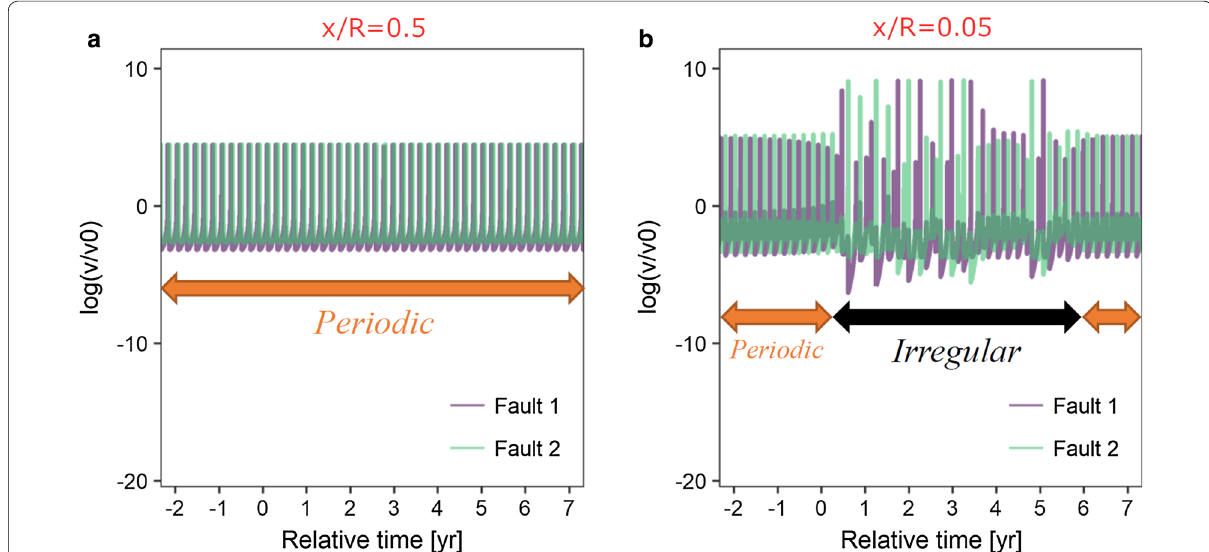
Fig. 3 Temporal evolution of the common logarithmic slip rate log( v / v 0 ) at the fault centers during multiple stick–slip sequence, in Case 2 with the aging law (same as Fig. 2). a In case of x / R